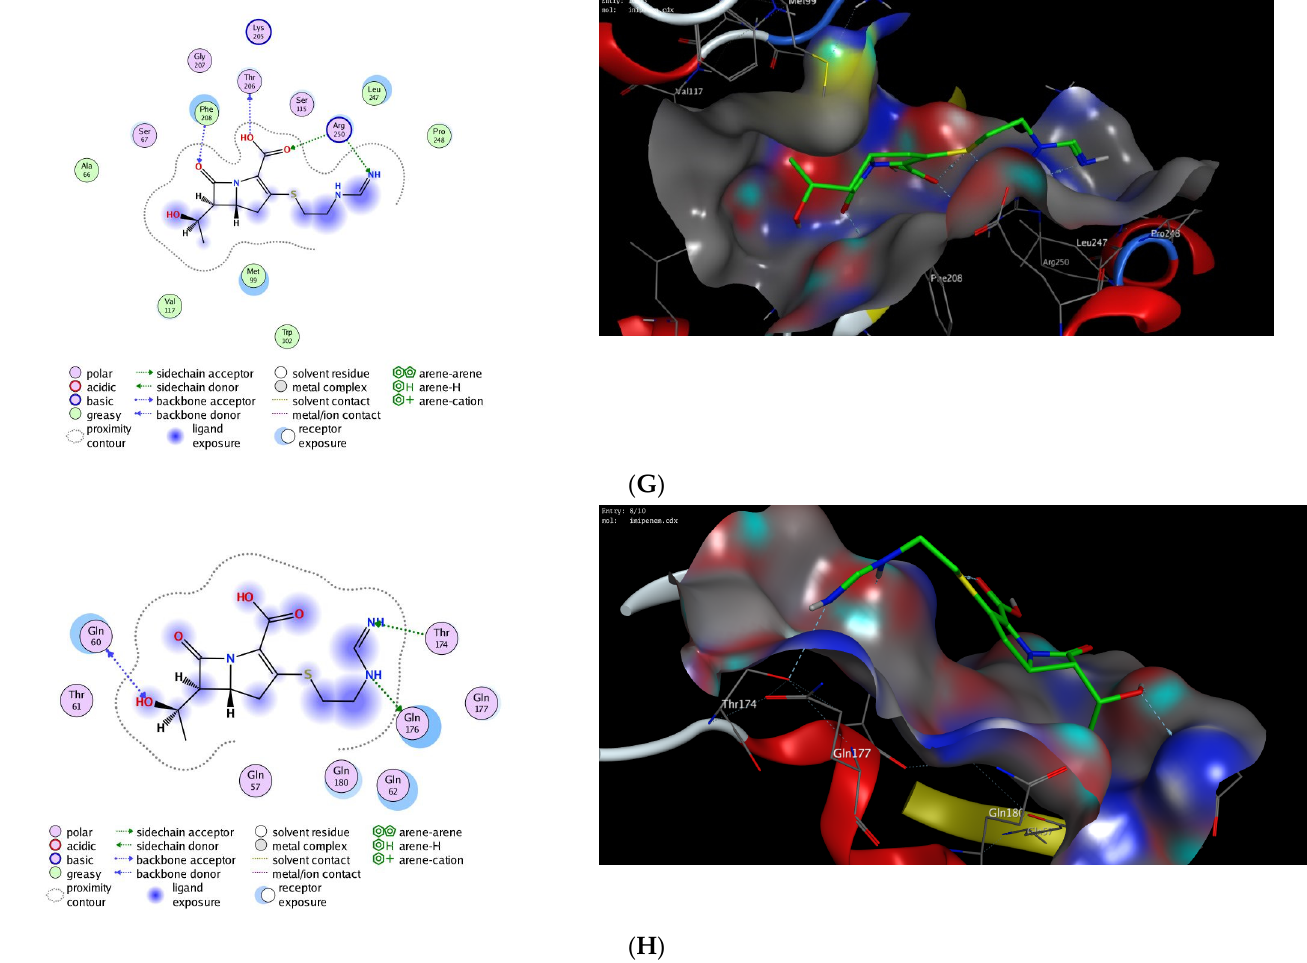
Figure 2. The 2D and 3D molecular docking interactions of imipenem (green in 3D interactions) with OXA proteins: OXA-23 ( A ), OXA-48 ( B ), OXA-23 A220 ( C ), OXA-24 ( D ), OXA-143 ( E ), OXA-655 ( F ), OXA-10 ( G ), and OXA-51 ( H ). The hydrogen bonds are illustrated as dotted blue arrows; (C atoms, green; S atoms, yellow; O atoms, red).